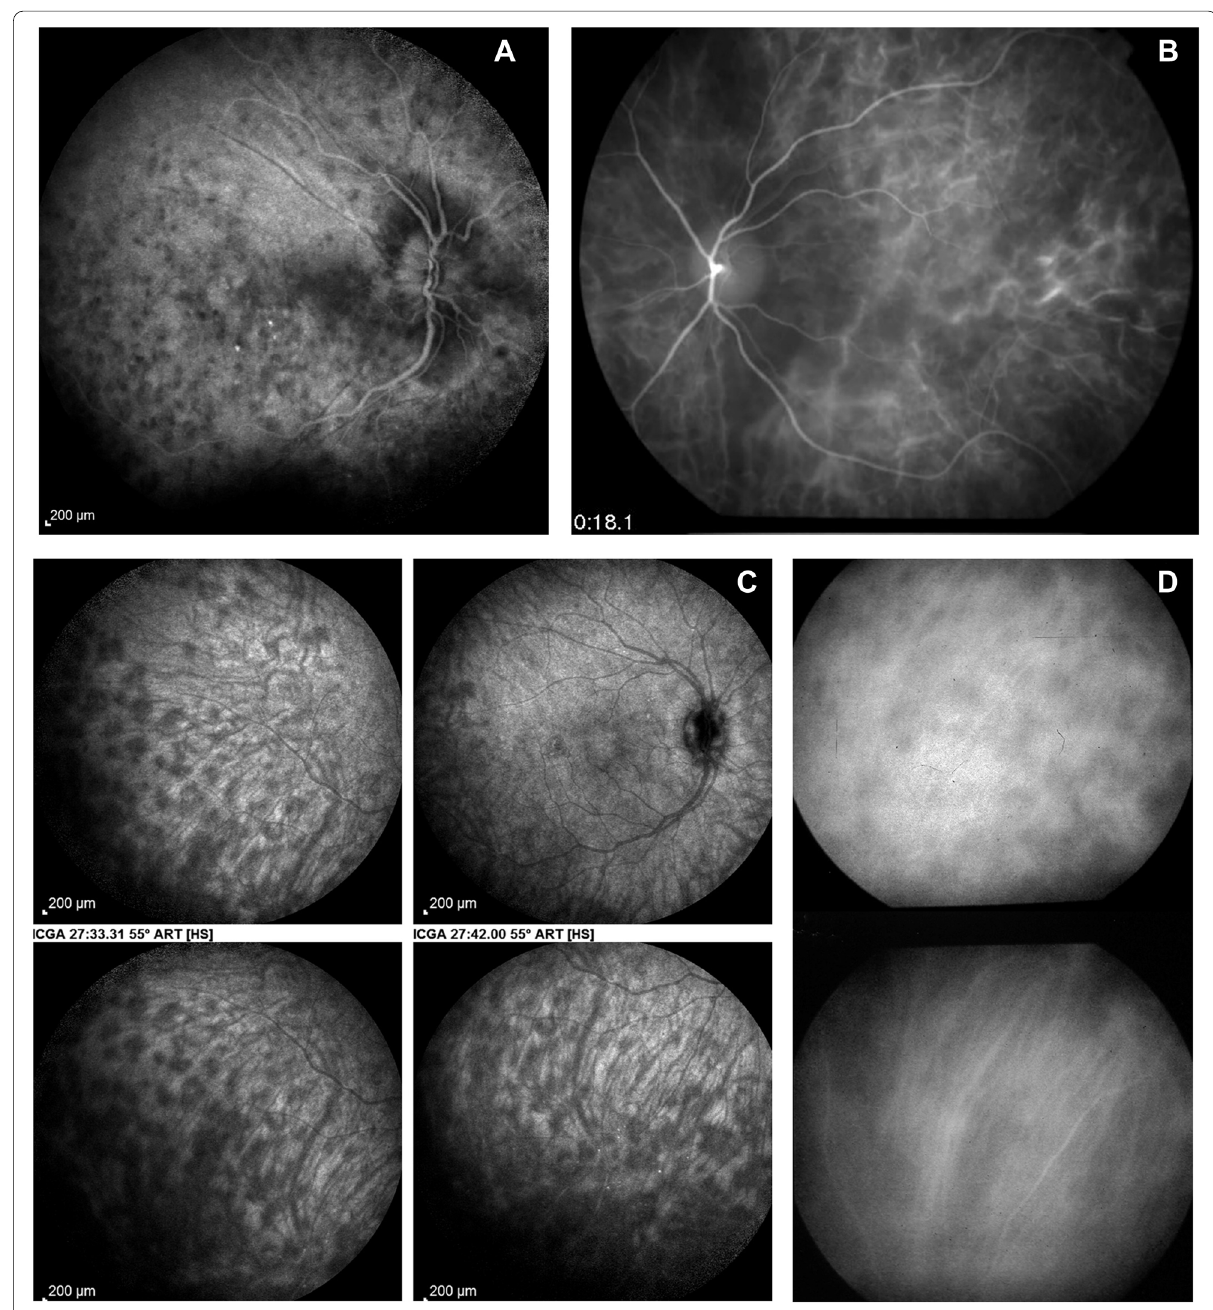
Fig. 8 Four main signs detected with ICGA in acute initial‑onset VKH disease. A Hyperfluorescent disc (usually hypofluorescent on ICGA), which indicates severe inflammation. B Early hyperfluorescent vessels. C Numerous, regularly distributed hypofluorescent dark dots (HDDs), evenly sized, over the whole fundus, is the most demonstrative and quantifiable ICGA sign. D ( top ) Fuzzy, indistinct choroidal vessels represent the fourth ICGA sign; ( Bottom ) After 3 days of intravenous methylprednisolone treatment, the course and structure of choroidal vessels are again distinctly